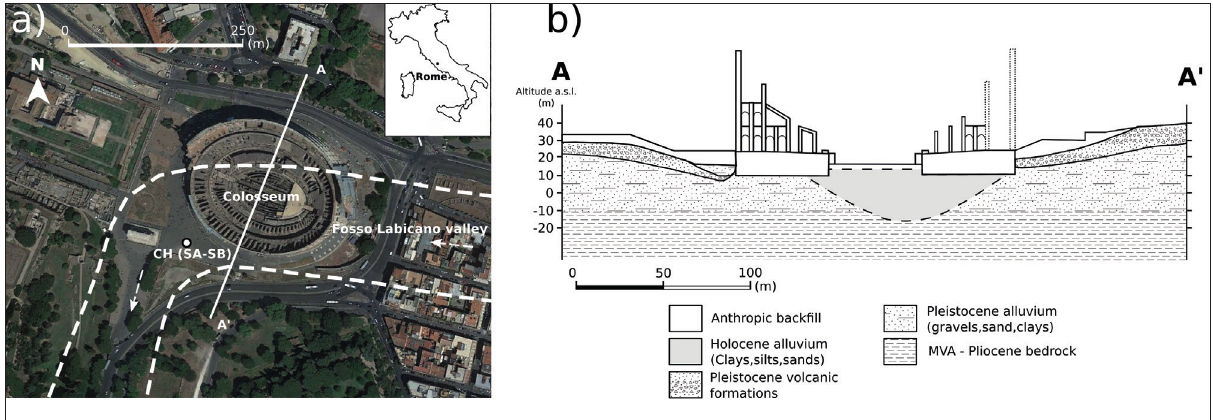
Figure 1. (a) Aeral view of the Colosseum with annoted the limits of the Fosso Labicano Valley and position of the boreholes (SA and SB) employed for crosshole investigations (CH). (b) : simplified geological section (A-A’) across the Colosseum Area. Figures redrawn after Funiciello et al. [1995] and modified according to Mancini et al.